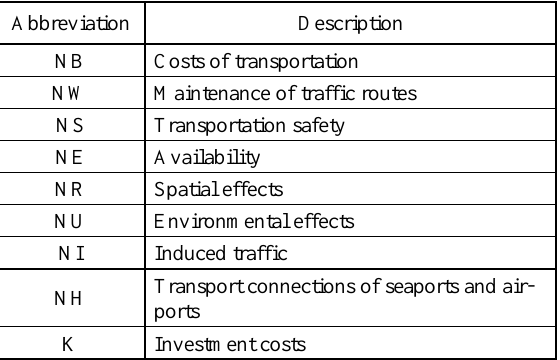
Table 2. Components for evaluation in the cost-benefit- analysis in the German general transportation